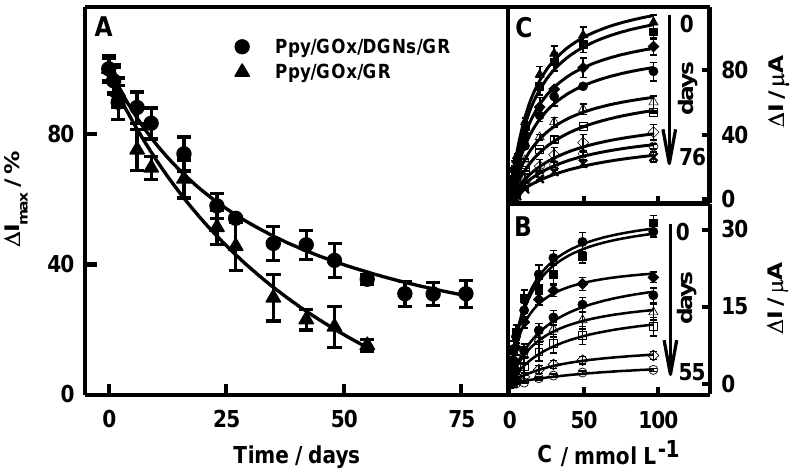
Figure 5. The changes of current responses over time ( A ) and calibration plots of biosensors based on the Ppy/GOx/GR ( B ) or Ppy/GOx/DGNs/GR ( C ) electrodes after 22 h of polymerization. The current responses of the Ppy/GOx/GR and Ppy/GOx/DGNs/GR electrodes to- ward glucose gradually decreased during the first 16 days to 66.2 and 73.9%, respectively (Figure 5A). From 23 to 35 days, current responses decreased from 51.4 to 29.7 and from 57.9 to 46.3%, respectively. The 1/2 for biosensors based on the Ppy/GOx/GR and Ppy/GOx/DGNs/GR electrodes were 22 and 33 days, respectively. The glucose biosensor fabricated using Ppy was 1.50 times more stable than electrode without Ppy ( 1/2 = 22 days) [44], and 1.50 and 1.94 times more stable than the GOx/PANI-AuNPs (6nm) -GOx/GR ( 1/2 = 22 days) or GOx/Ppy-AuNPs (6nm) -GOx/GR ( 1/2 = 17 days) electrodes [48]. Moreover, use of Ppy made it possible to achieve 3.37 and 4.71 times higher stability in comparison with biosensors based on the Ppy/GOx/AuNPs( el depos.) /GR electrode ( 1/2 = 9.8 days) [23] and based on the GOx/PANI/Au nanorods/Pt electrode ( 1/2 = 7.0 days) [25], respectively. The registered current response decay might be based on the decreased activity of the enzyme during the storage and repeated measurements of the Ppy/GOx/DGNs/GR electrode, as was reported in previous researches [46,50]. 3.5. The Influence of Interfering Species on the Current Response of Designed Biosensor and the Accuracy of Glucose Assessment in Real Samples Glucose and fructose are the most relevant sugars for detection in real samples [10]. Saccharose, xylose, galactose, mannose, and fructose are stereoisomers of glucose with the same molecular formula and sequence of bonded atoms. Interfering materials such as ascorbic and uric acids are electrochemically active and are able to affect the electrochem- ical current response of the glucose biosensor [10,17,25]. The main contribution of the car- boxylate group presented in polymeric structures is the exclusion of the matrix effects [25]. The selectivity tests of the glucose biosensor to saccharose, xylose, galactose, man- nose, and fructose, as well as to electrochemically active AA and UA, were conducted and presented in this paper. As an example, the influence of interfering species on the current response of the Ppy/GOx/DGNs/GR electrode was tested in a 10-times-diluted sample of human serum containing 10.0 mmol L −1 glucose after the addition of 1.0 mmol L − 1 saccha- rose, xylose, galactose, mannose, or fructose (Figure 6A). It was determined that these substrates are not influencing the current response of the biosensor towards glucose.